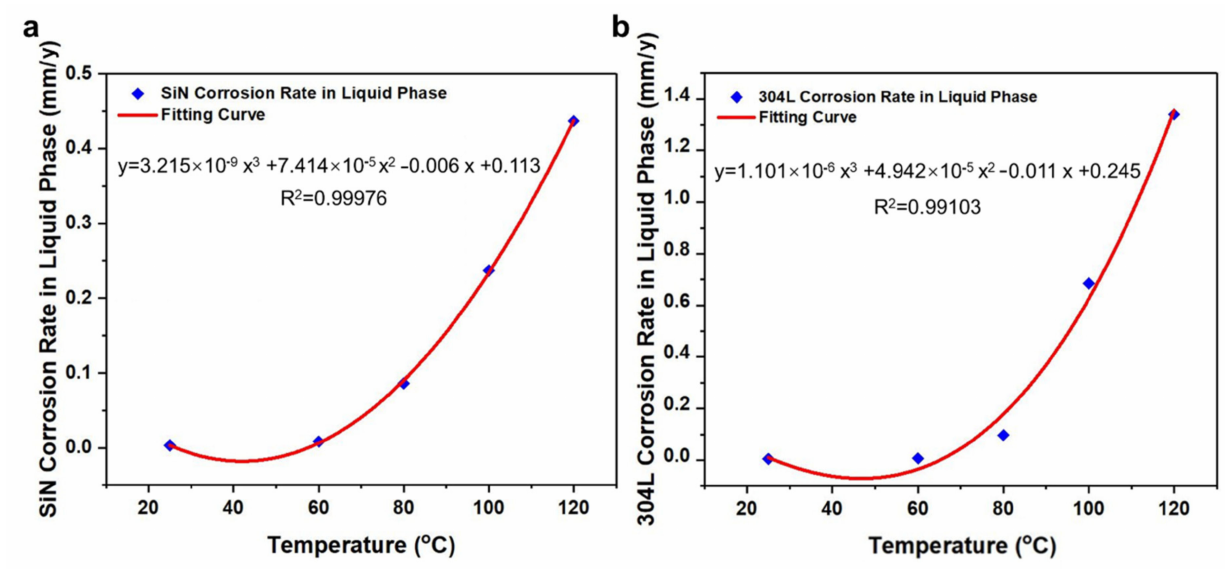
Figure 3. Corrosion rate fitting curves of SiN and 304L stainless steels in nitric acid liquid phase at different temperatures, ( a ) SiN stainless steel and ( b ) 304L stainless